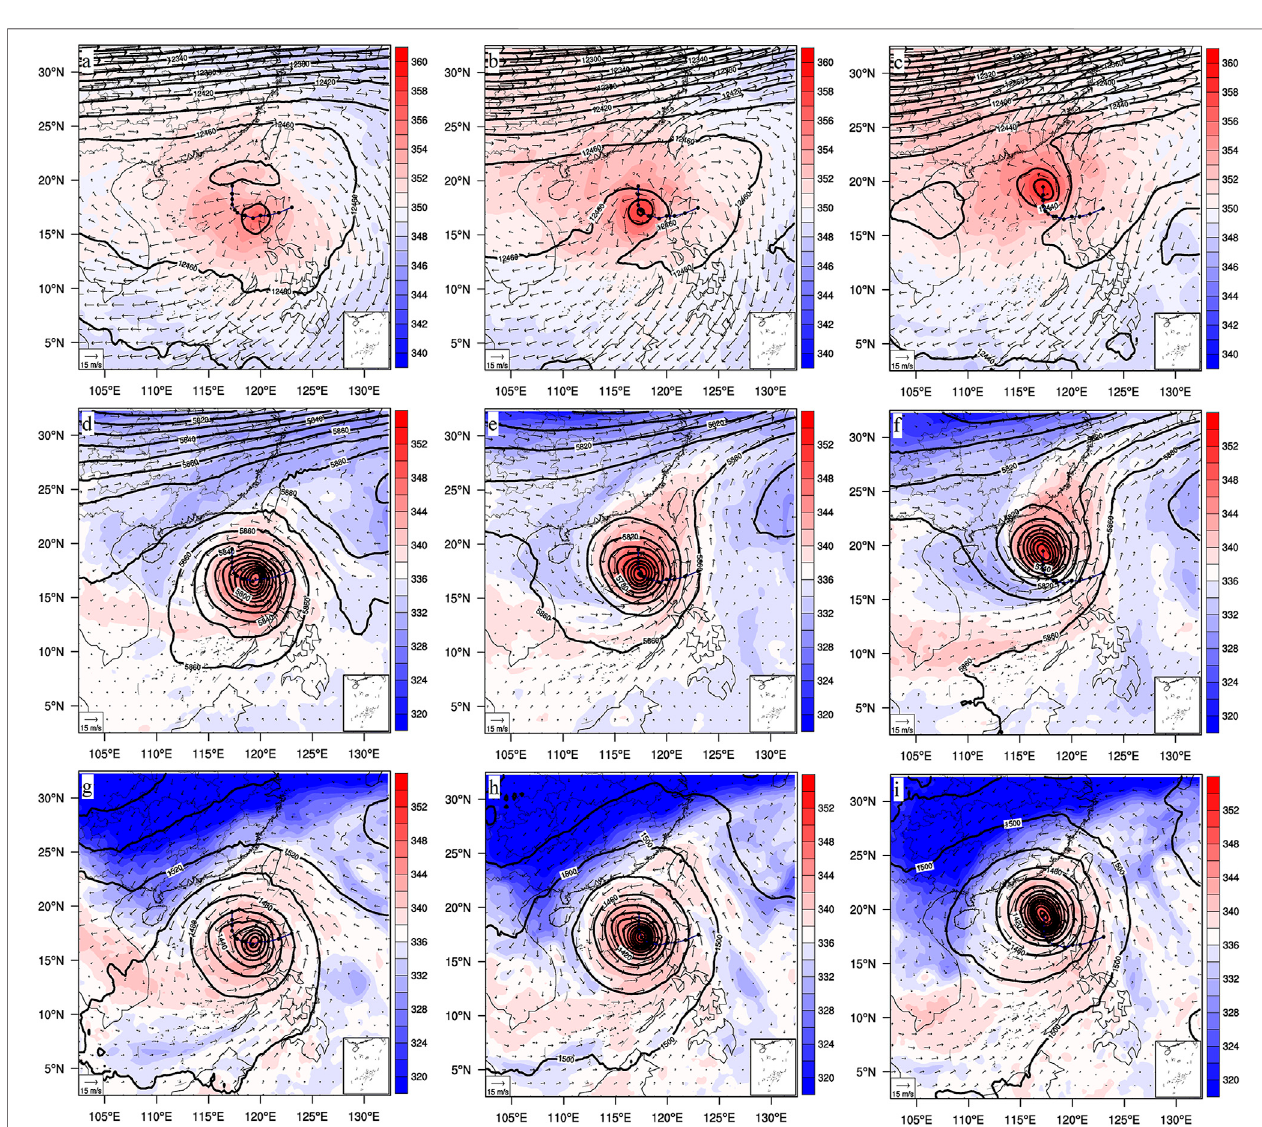
FIGURE2| Thecompositedcirculationevolutionatheightof200 (A , B ,and C) ,500 (D , E , F) ,and850-hPa (G , H , I) (Figs.A,D,andGareatT-24, fi gs.B,E,andH areatT, fi gs.C,FandIareatT+24;linesaregeopotentialheight,Unit:gpm;vectorsarewinds, Unit:m s − 1 ;theshadedareasareequivalentpotentialtemperature(EPT), Unit: